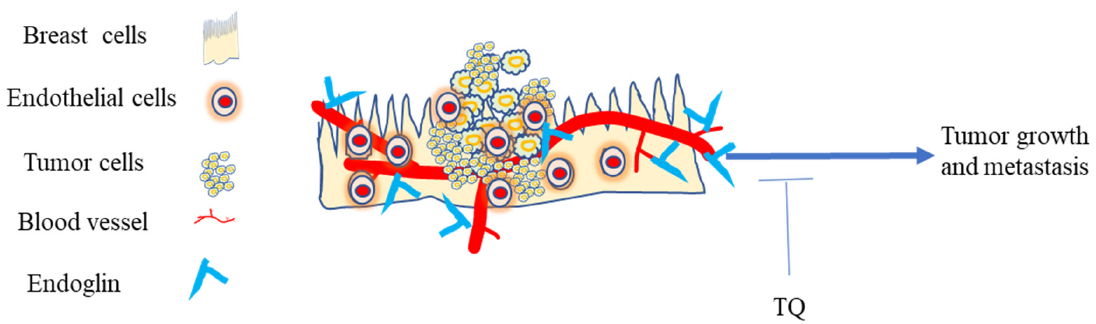
Figure 6. Endoglin in the TME of TNBC. The expression of endoglin on endothelial cells is critical for promoting primary tumor growth and metastasis. Blocking endoglin in the TNBC TME with TQ exerts anti-cancer activity.